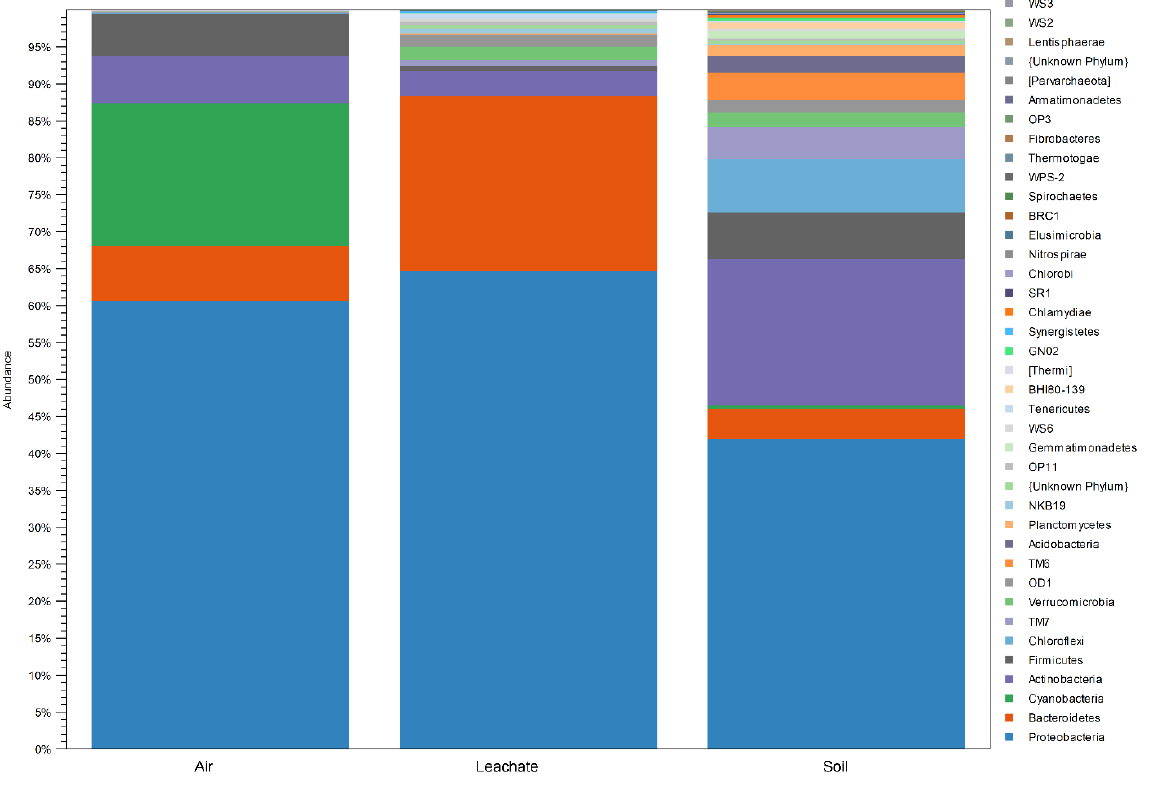
Figure 7. Percentage of identified bacteria at the Phylum level based on the analysis of the V3/V4 region of the gene encoding the 16S rRNA.